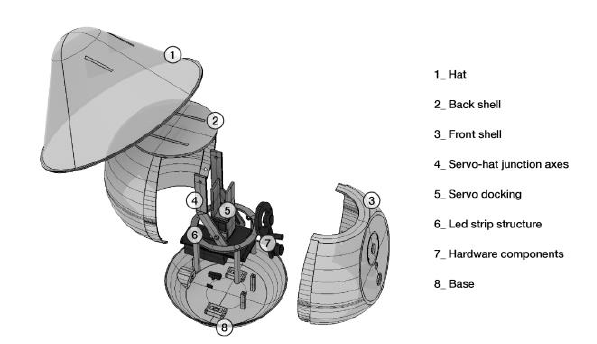
Figure 10 | 3D model of the robot’s components.